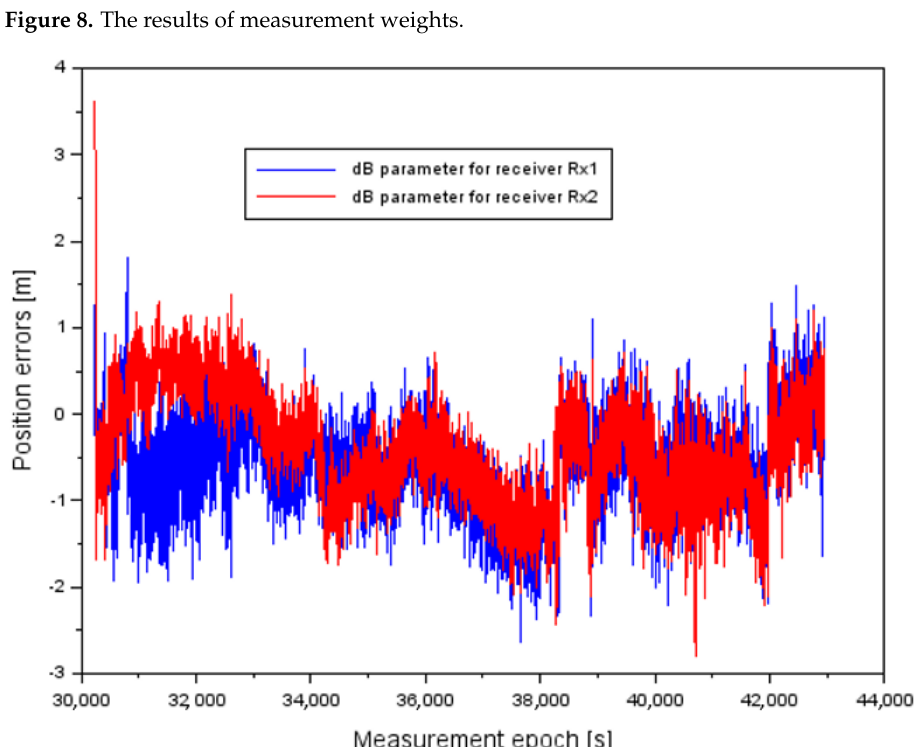
Figure 9. The results of 𝑑𝐵 position errors for 𝑅𝑥1 and 𝑅𝑥2 receivers.